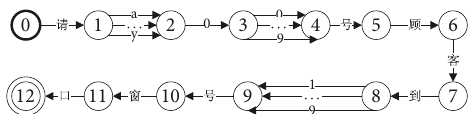
Figure 6: Finite state transducer of the grammar